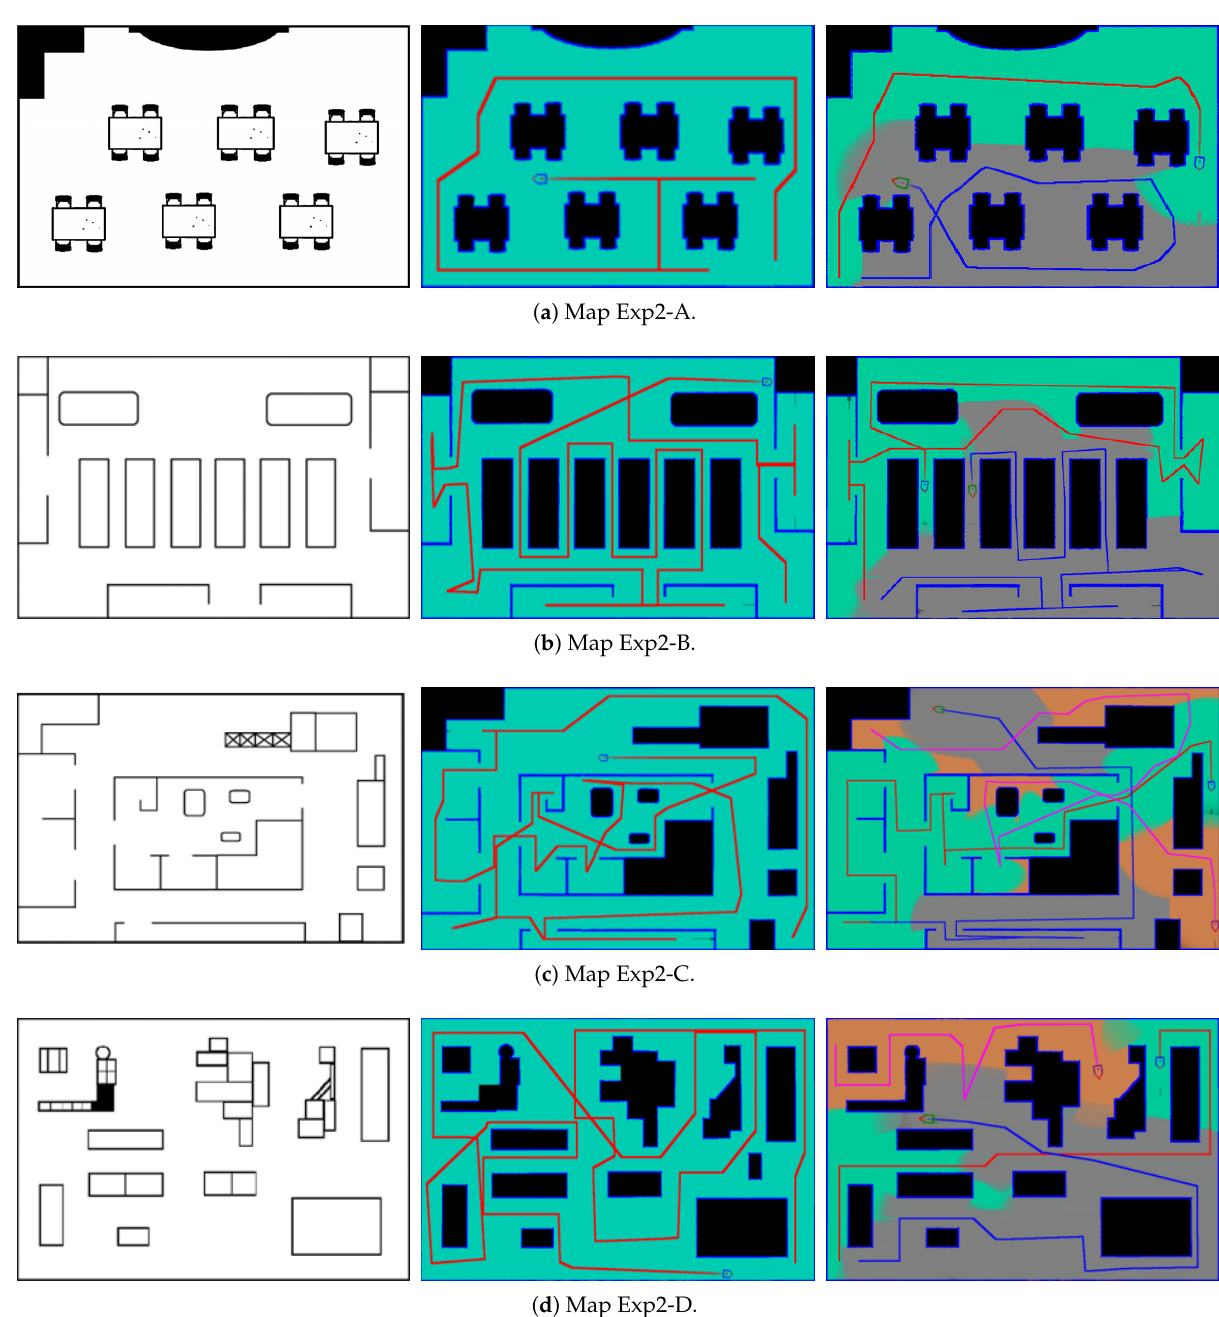
Figure 5. The efficiency of our algorithms is evaluated using four different maps. The left to the right: the original maps, the coverage results of single robot, the coverage results of multiple